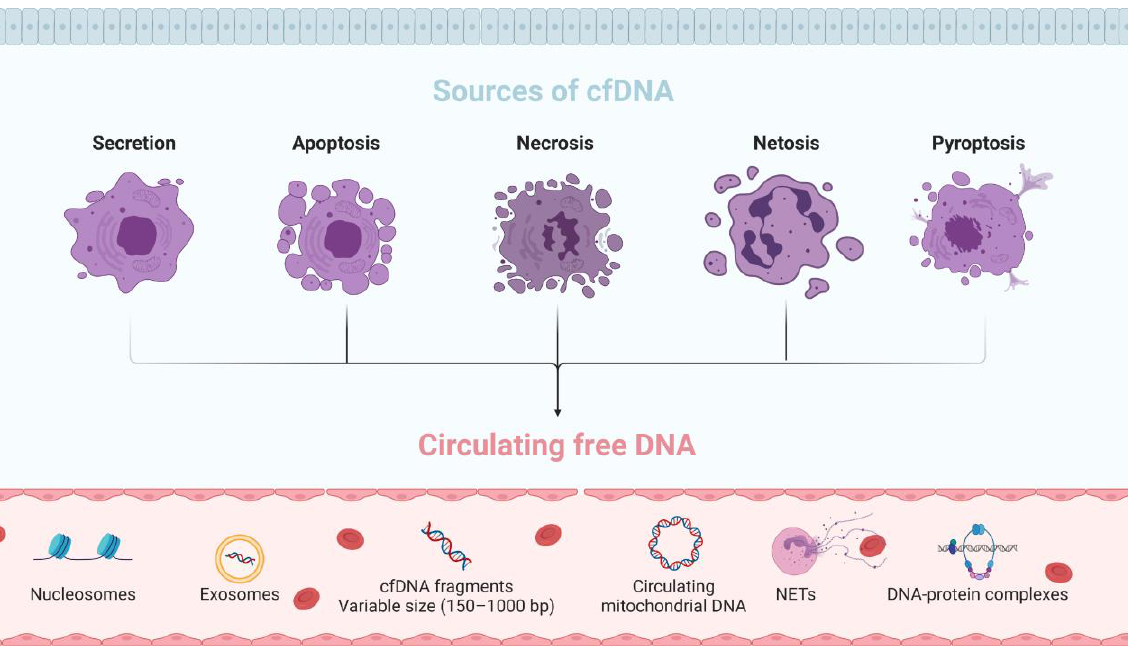
Figure 1. Mechanisms involved in the release of cell-free DNA. Secretion . Most cfDNA release into the circulation is associated with active